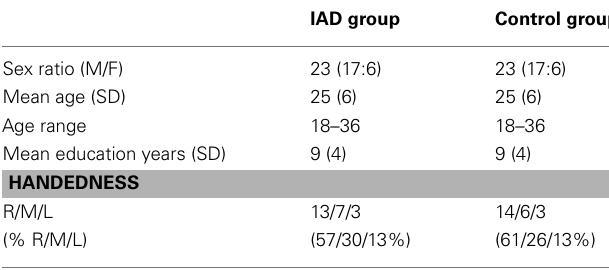
Table 1 | Demographic characteristics of the sample.